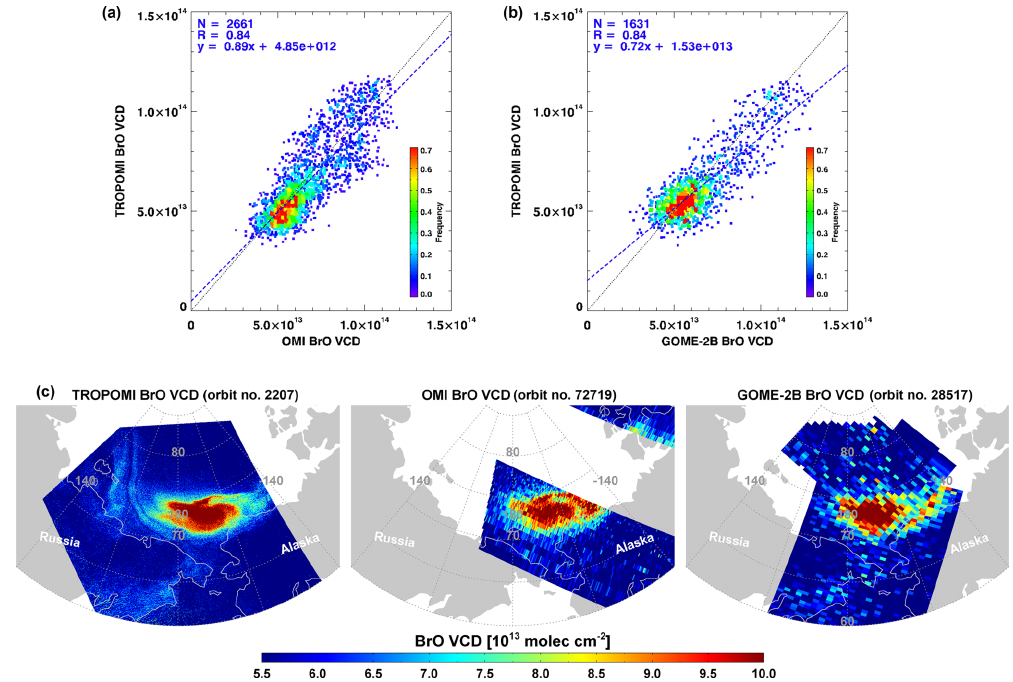
Figure 12. Scatter plots of (a) TROPOMI and OMI BrO vertical columns and (b) TROPOMI and GOME-2B BrO vertical columns in (c) the selected region of enhanced BrO plumes on 17 March